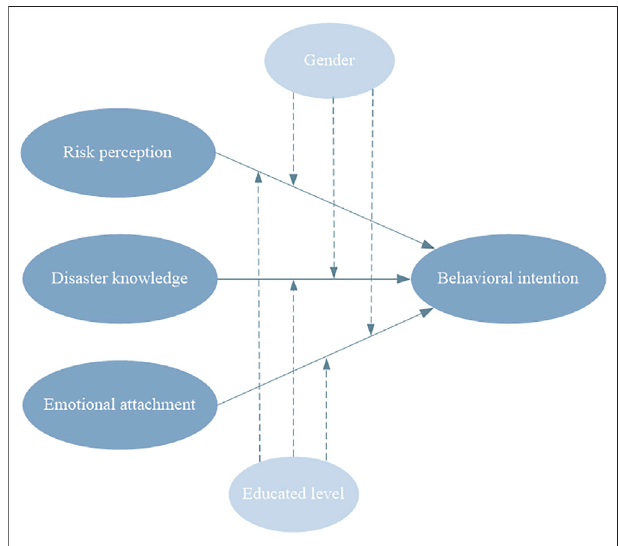
FIGURE 1 | Theoretical framework and conceptual